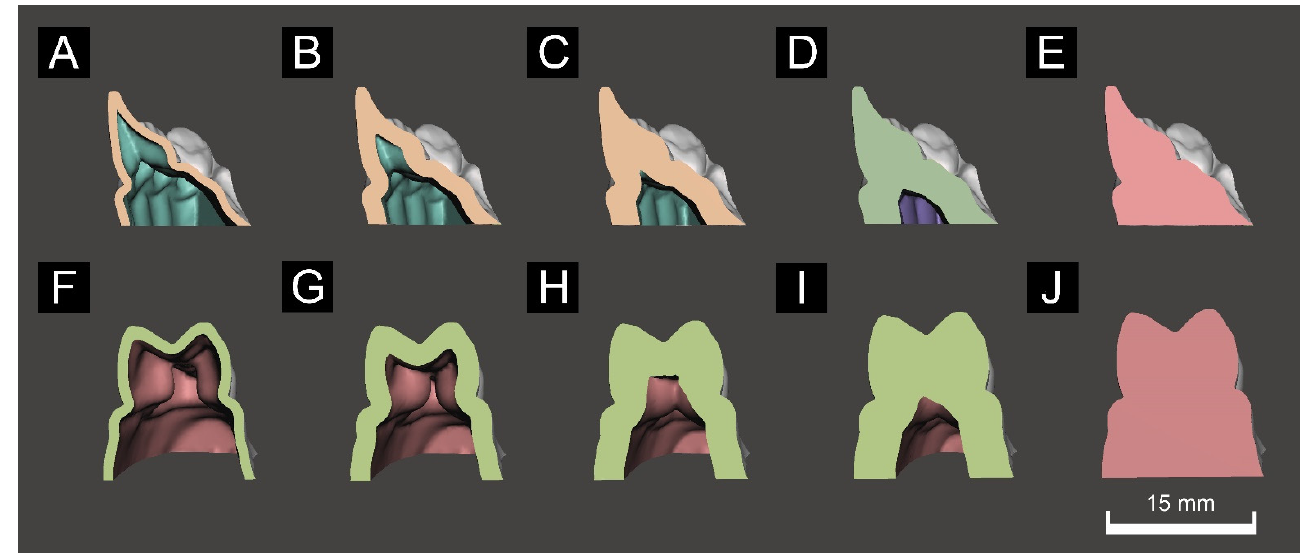
Figure 3. Cross sections of the 3D printed models. The anterior partial-arch groups consisted of a ( A ) 1-mm-thick shell model, ( B ) 2-mm-thick shell model, ( C ) 3-mm-thick shell model, ( D ) 4-mm-thick shell model, and ( E ) fully filled model. The posterior partial-arch groups consisted of a ( F ) 1-mm-thick shell model, ( G ) 2-mm-thick shell model, ( H ) 3-mm-thick shell model, ( I ) 4-mm-thick shell model, and ( J ) fully filled model.